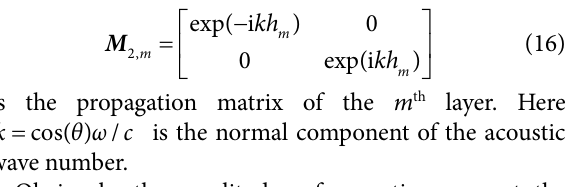
Fig. 7 | Variation in the absorption under different coherent conditions. ( a ) Absorption versus frequency f with path difference of l =0.2 m. ( b ) Absorption versus l at f = 10 kHz.